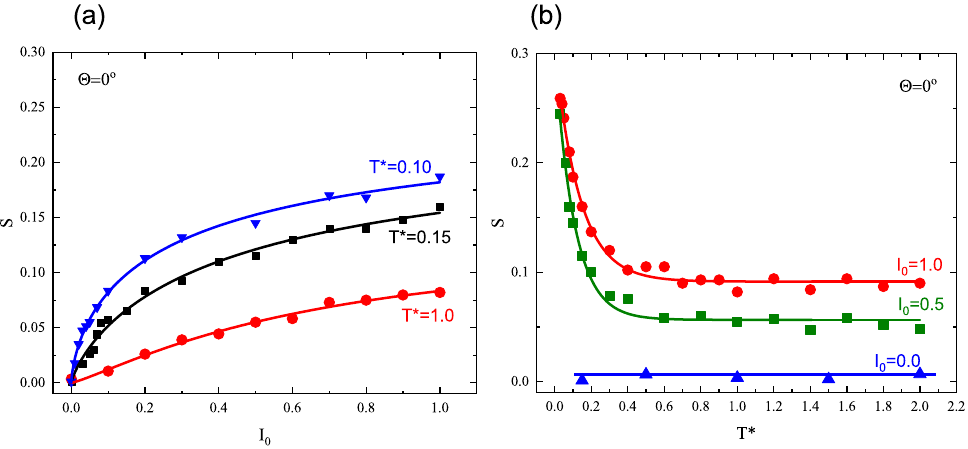
Figure 5. Scalar order parameter S for FPM after illumination time of 10 4 MCS as function of: light intensity I 0 ( a ); and temperature T ∗ ( b ). Experimental errors are of the size of graphical